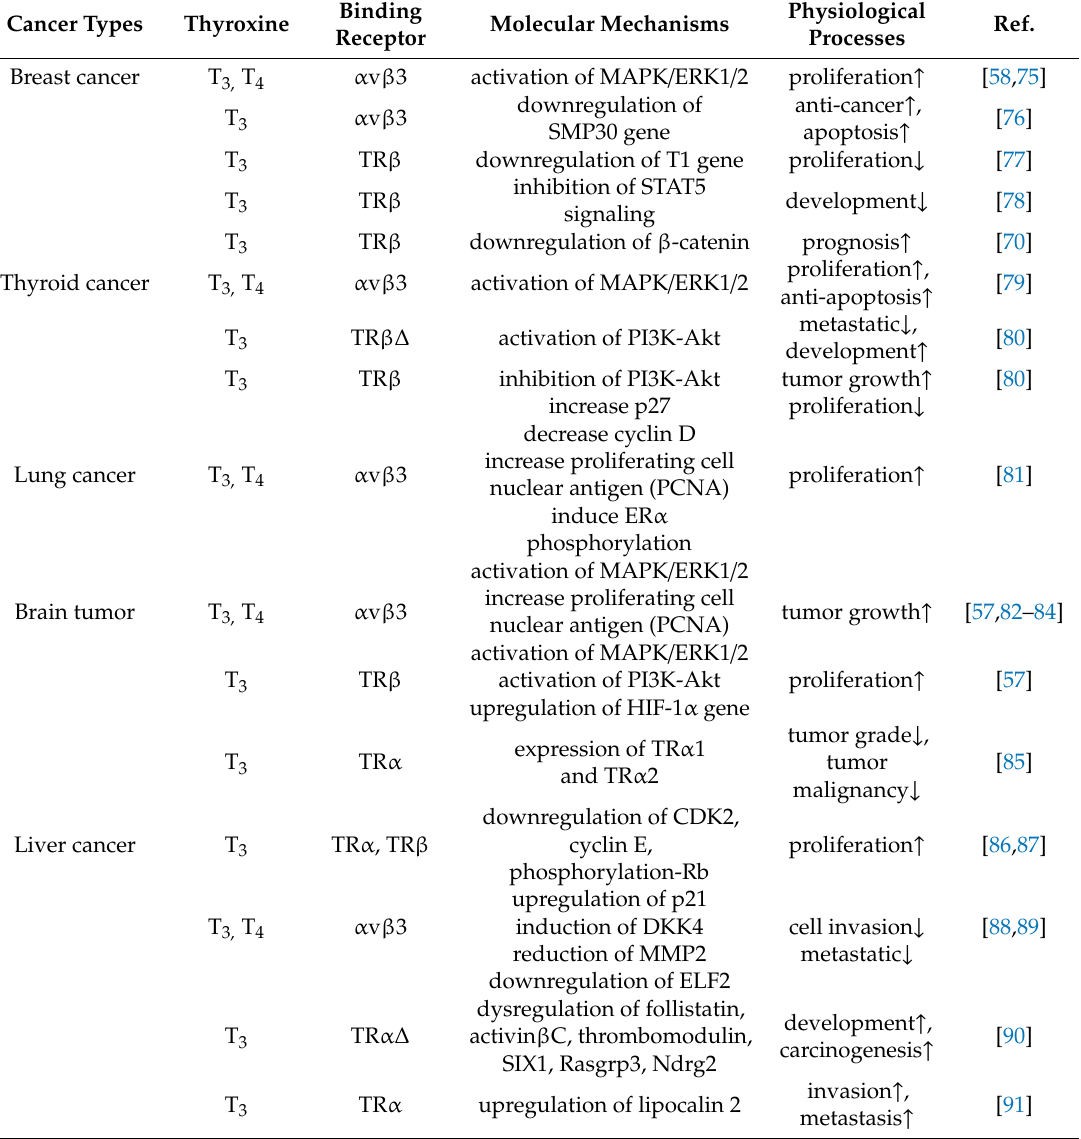
Table 1. Summary of the relevant molecular mechanism in di ff erent kinds of cancer via THs /